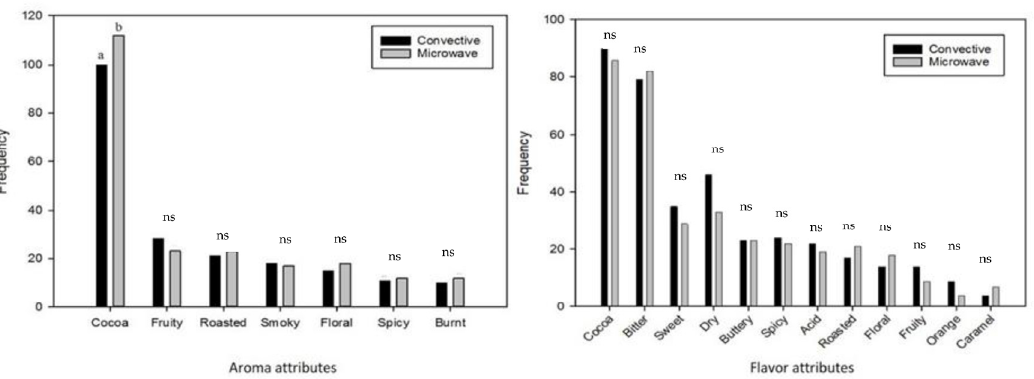
Figure 1. Bar chart representing the usage frequencies of 7 aroma attributes ( left ) and 12 flavor attributes ( right ) detected by consumers (n = 130) in chocolate produced from convectively and microwave roasted cocoa beans. Only cocoa aroma was significantly more applicable for the microwave chocolate samples, as indicated by different lower case letters a and b; the others were non-significant (ns) ( p < 0.05).